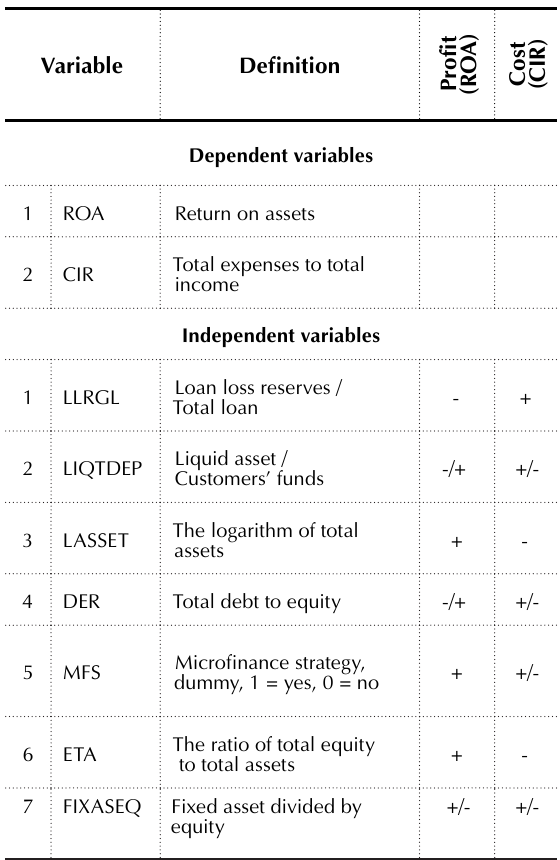
Table 1. Variable, measurement and expected